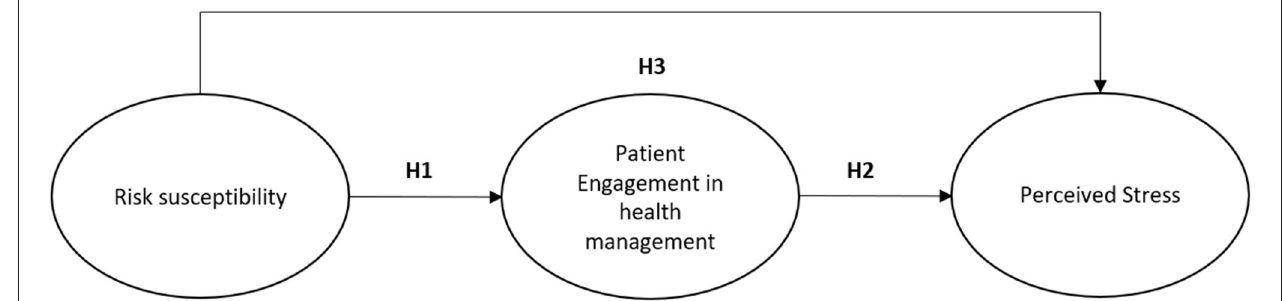
FIGURE 1 | The hypothesized